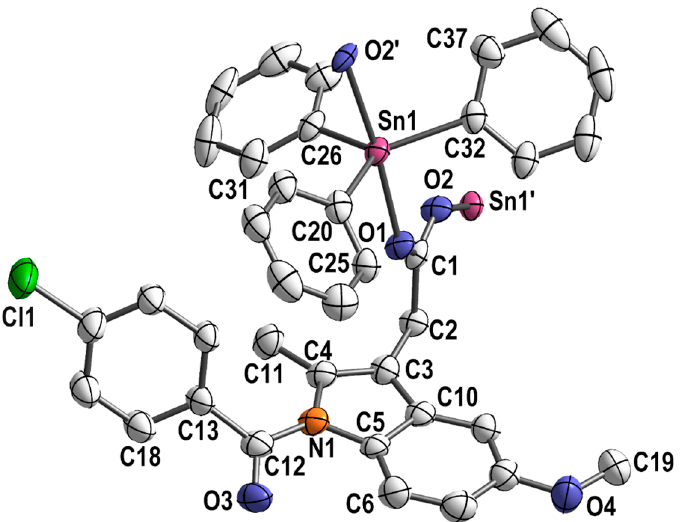
Figure 2. Section of the polymeric structure of [Ph 3 Sn(IND)]; hydrogen atoms and solvent molecules are omitted for clarity; thermal ellipsoids are set at 50% probability level.